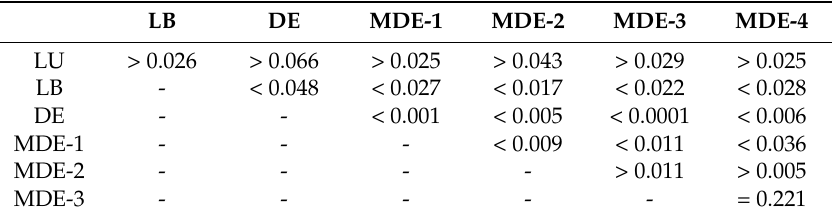
Table 14. Statistical test results (paired t